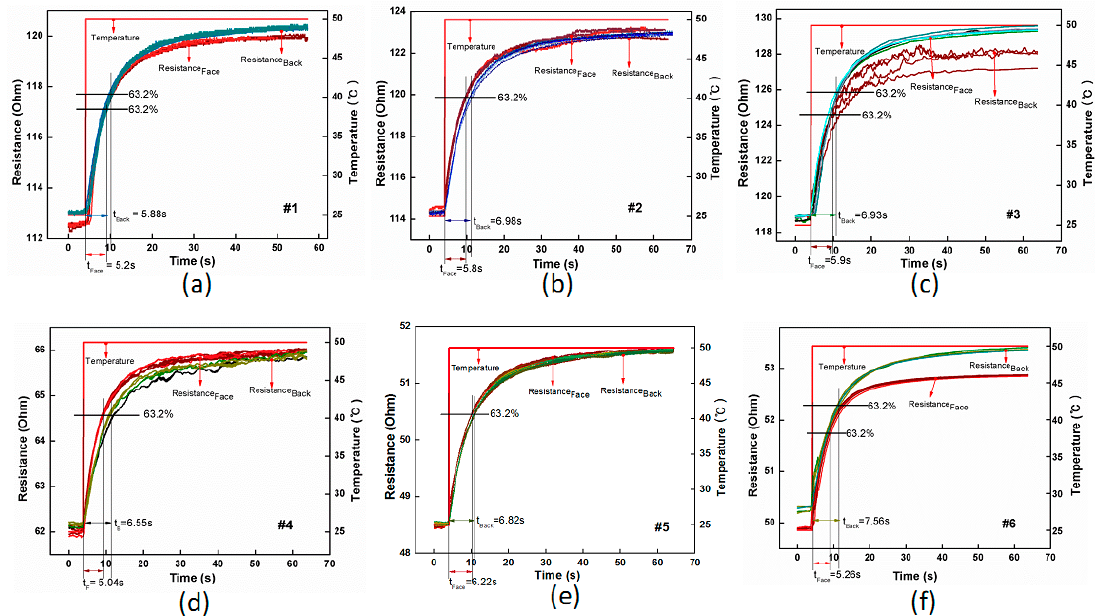
Figure 12. Response time of all the fabric temperature sensors on hotplates. ( a ) Sample No.1 with front and back sides; ( b ) Sample No.2; ( c ) Sample No.3; ( d ) Sample No.4; ( e ) Sample No.5; ( f ) Sample No.6. Table 6. Response time of fabric sensors with face and back sides on heating plate.